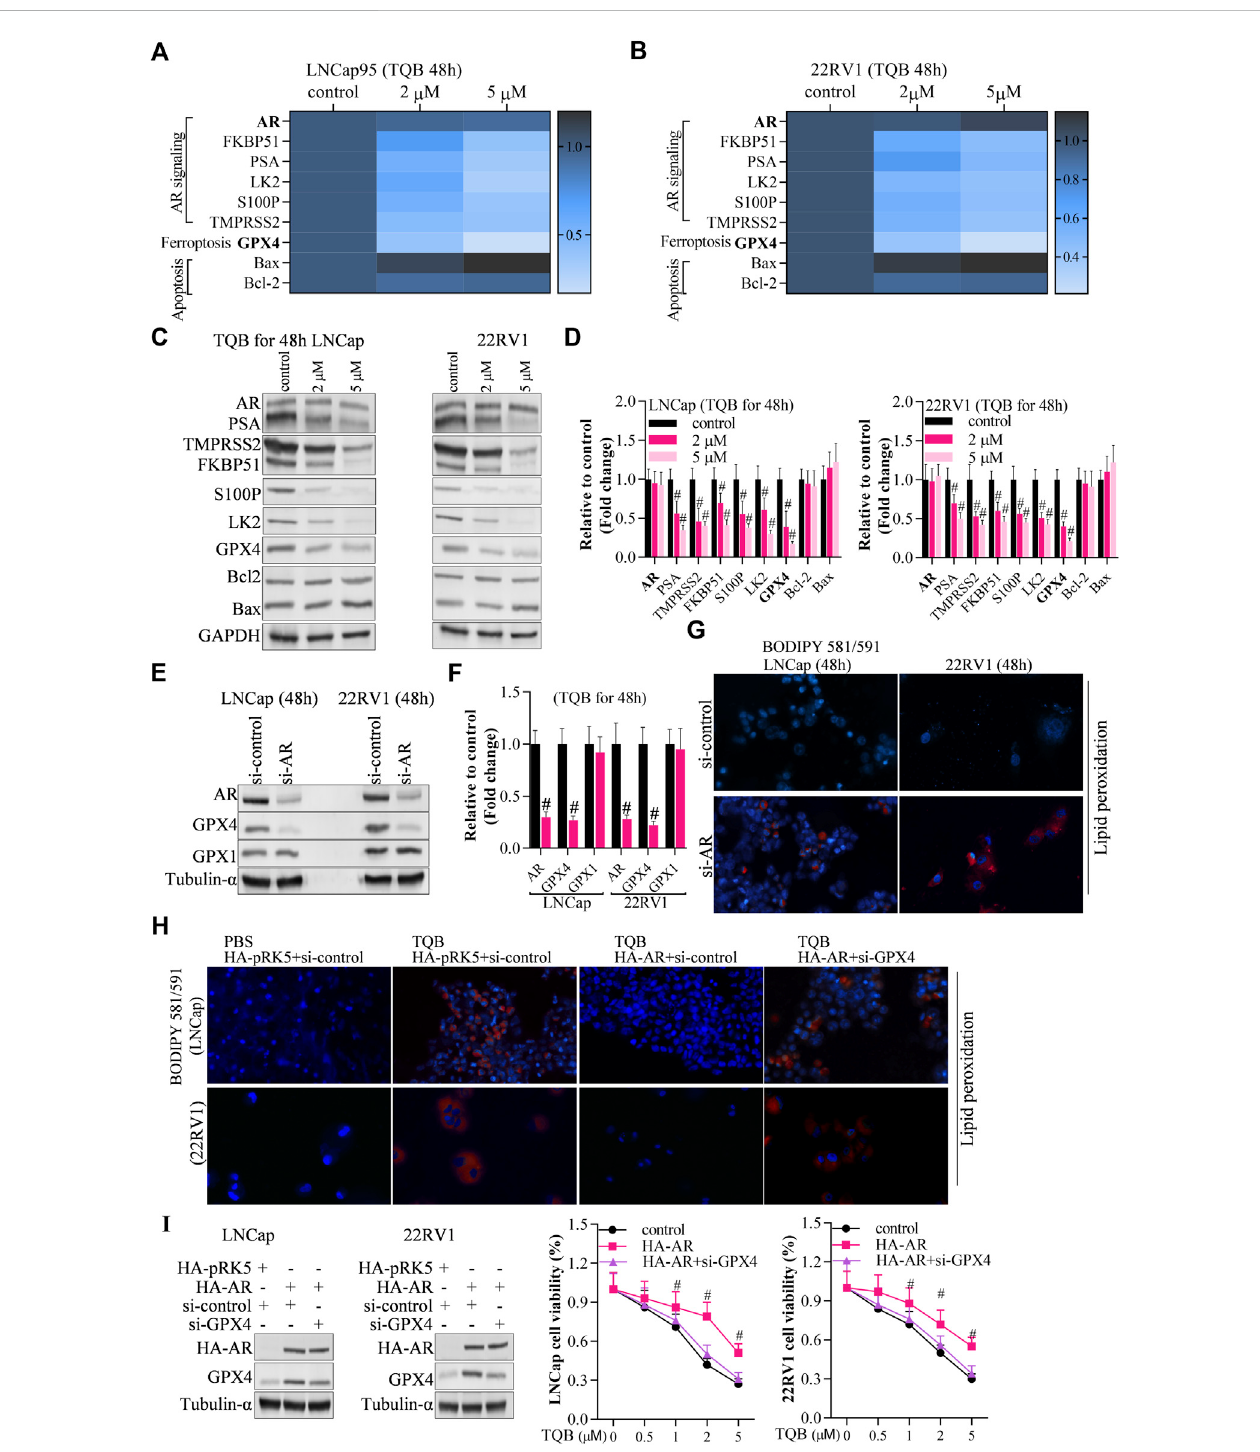
FIGURE 3 TQB3720 induced ferroptosis via AR-GPX4 axis (A,B) RT-qPCR detected the effects of on expression of genes in AR signaling pathway, ferroptosis pathway, and apoptotic pathway, # p < 0.01 vs. control. (C,D) Westernblotexamined theeffects ofon expression of genesinAR signaling pathway, ferroptosis pathway, and apoptotic pathway, # p < 0.01 vs. control. (E,F) Western blot determined the expression of AR and GPX4 after knockdown of AR, # p < 0.01 vs. si- control. (G) The BODIPY 581/591 assay revealed the effects of AR knockdown on lipid peroxidation. Blue indicates the hochest stained nuclei, and red indicates lipid peroxidation levels. (H) The cells were transfected with HA-AR for 24 h after knocking down GPX4 for 48 h, and then they were incubated with 5 μ M TQB3720 for another 48 h. The BODIPY 581/591 assay was used to determine the lipid peroxidation levels indicated by hochest-stained nuclei in blue andlipidperoxidationinred. (I) ThecellsweretransfectedwithHA-ARfor24 hafterknockingGPX4downfor48 handthenincubatedwith5 μ MTQB3720for another 48 h, and then, MTT assay was used to detect the cell proliferation, # p < 0.01 vs.